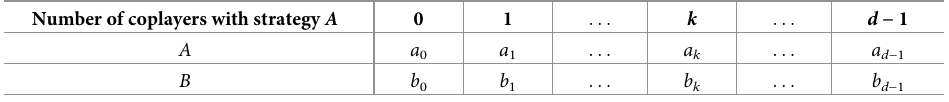
Table 1. Payoff table. Number of coplayers with strategy